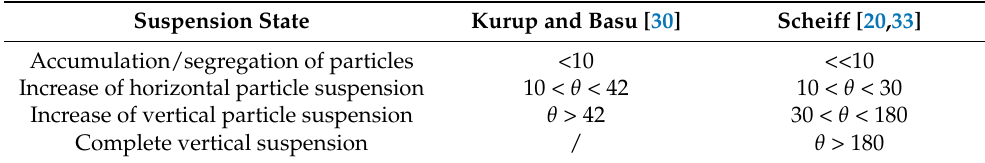
Table 1. Limits for the classification of the particle suspension state inside slugs based on the Shield parameter θ